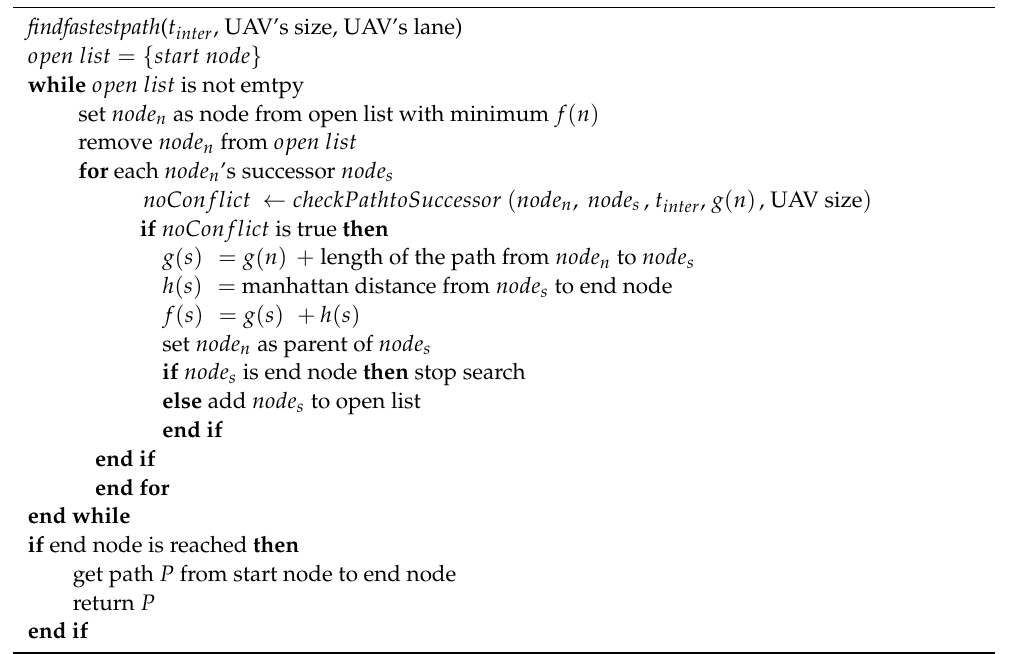
Algorithm 2 Finding the fastest path from start node to end node given the UAV will enter